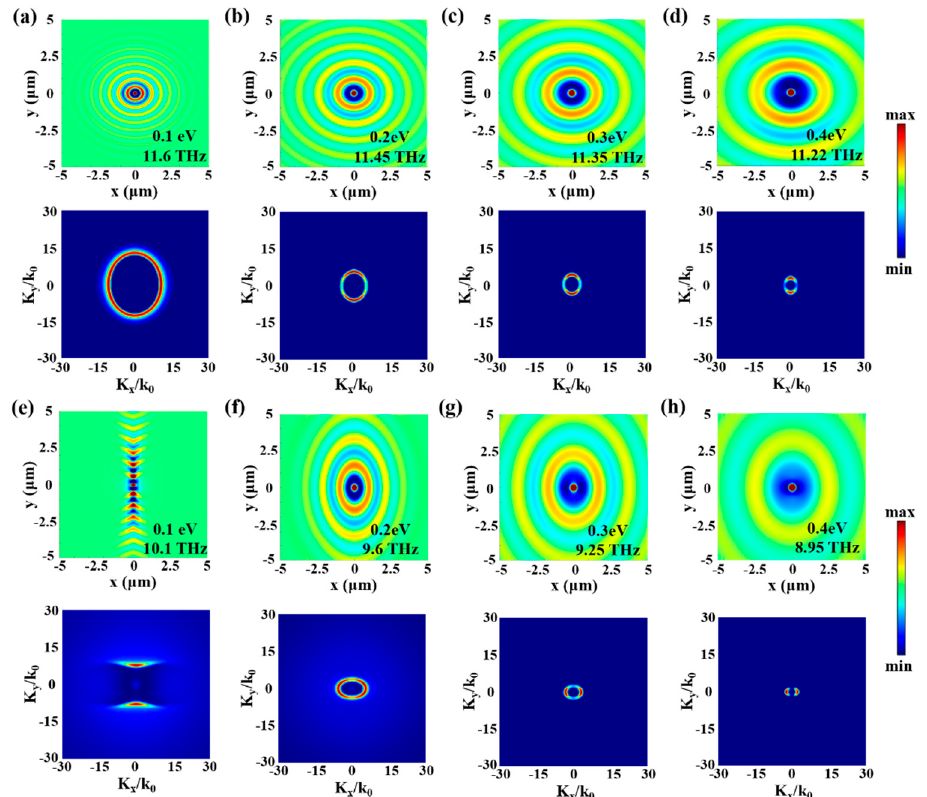
Figure 5. Hybrid polariton evolution in graphene/ α -MoO 3 heterostructure as a function of frequency and Fermi energy. ( a – d ) Simulated electric field spatial distribution ( top panels ) and corresponding colorplots IFCs ( bottom panels ) of hybrid polaritons at high-frequency bands for Fermi energies of 0.1, 0.2, 0.3, and 0.4 eV, respectively. ( e – h ) Electric field spatial distribution ( top panels ) and the corresponding colorplots IFCs at the low-frequency band.